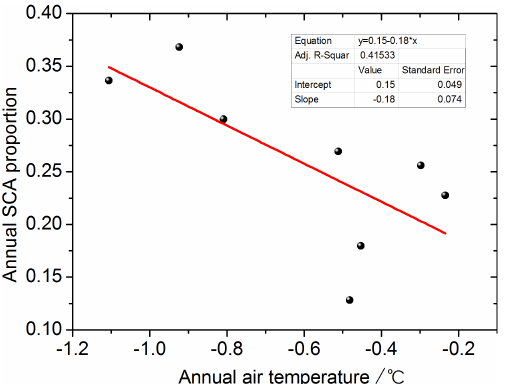
Fig. 13. Change trends of annual SCA proportion, air temperature and potential snowmelt from 2000 to 2008.